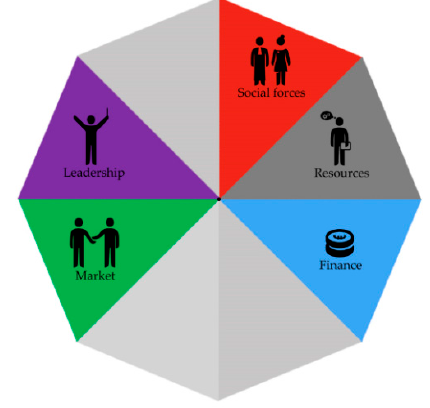
Figure 8. Understanding whom to engage and when.